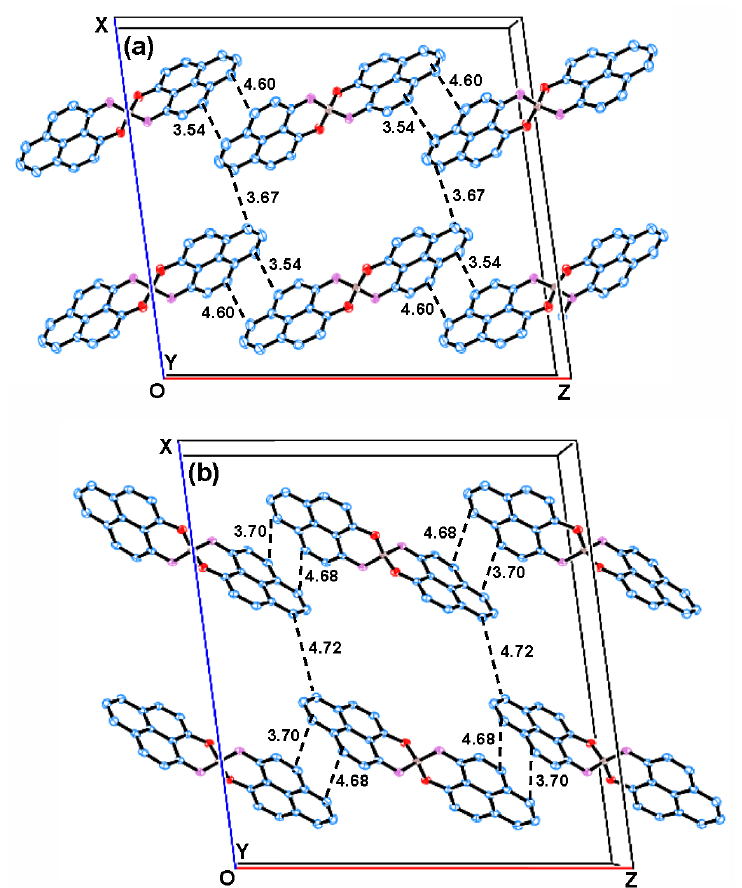
Figure 4. Packing of the molecules in xz plane for 7 ( a ) and 11 ( b ). Molecules are viewed along y axis, showing the contacts between spin-bearing carbon atoms. Benzyl and cyclohexanemethyl groups are omitted for